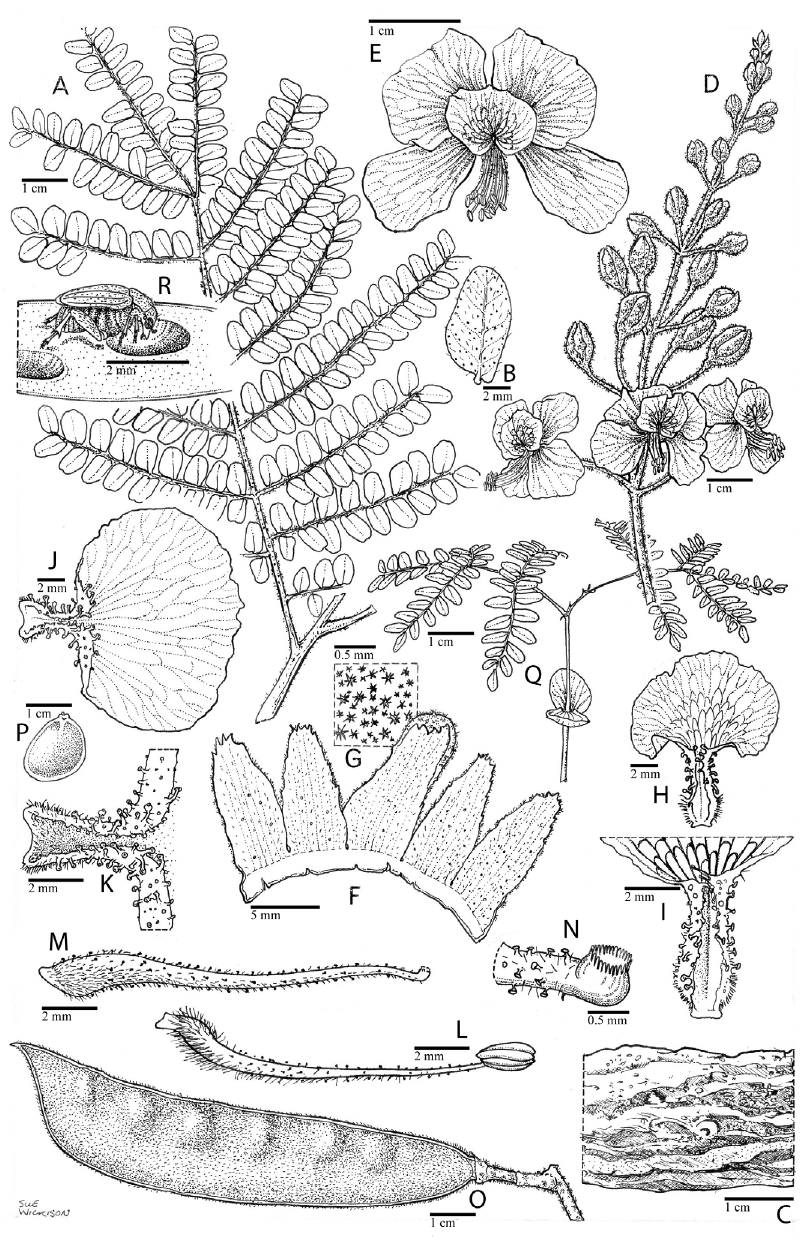
Figure 29. Cenostigma eriostachys (Benth.) E. Gagnon & G. P. Lewis . A part of bipinnate leaf B median leaflet undersurface, C section of branchlet bark D inflorescence E flower F calyx opened out G detail of stellate hairs on calyx H median petal I median petal claw J upper lateral petal K detail of lateral petal claw L stamen M gynoecium N stigma O fruit P seed Q seedling R bruchid emerged from seed. A, B, P–R from Lewis & Hughes 1799 C from Lewis et al. 1719 D–N from Lewis et al. 1718 O from Lewis & Hughes 1775. Drawn by Sue